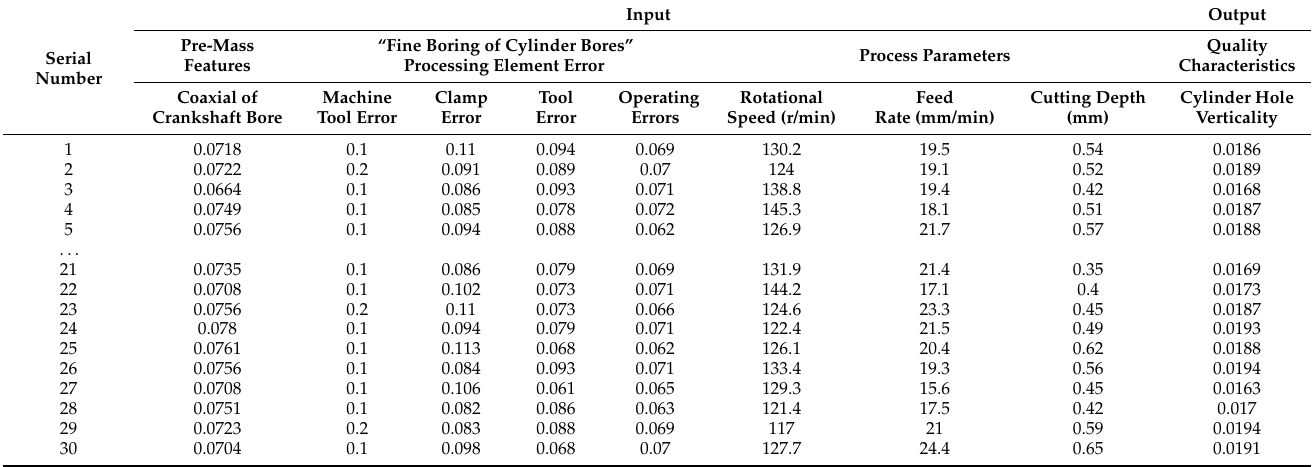
Figure 8. Flow chart of the optimized SVR algorithm. Table 2. Cylinder hole verticality experiment sample data